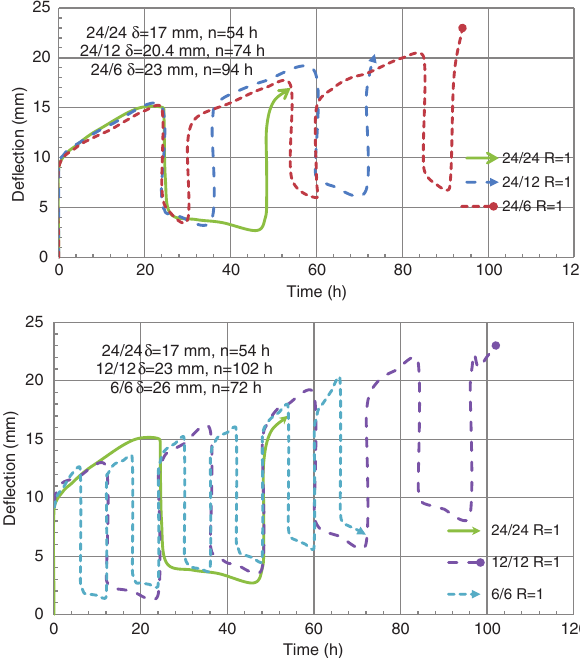
Figure 3: Typical R = 1 test results showing the dependence on the relaxation